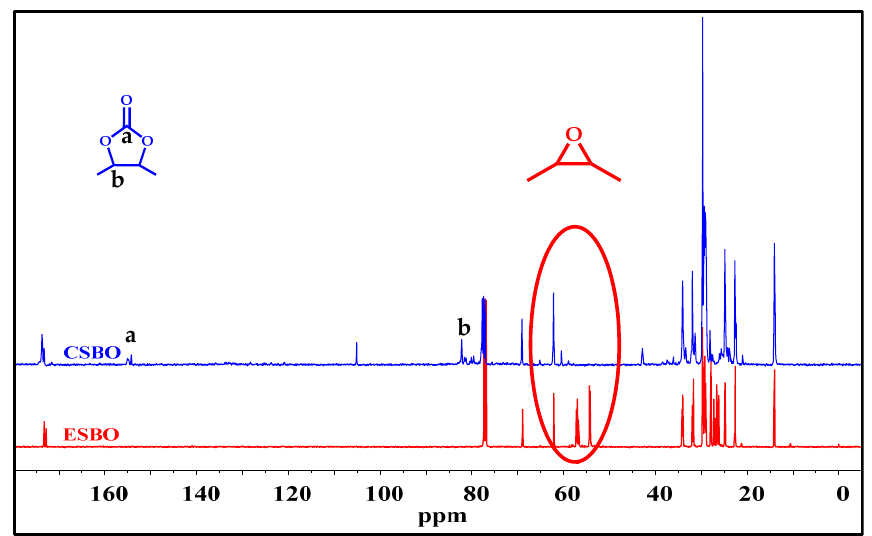
Figure 5. 13 C NMR of ESBO and CSBO.